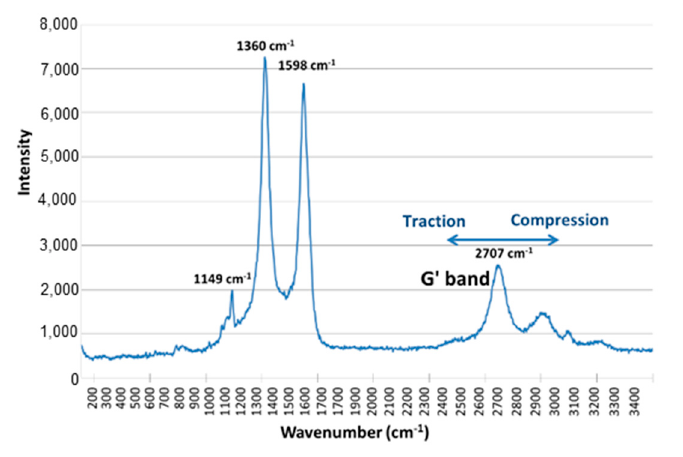
Figure 14. Raman spectrum of a MWNT-based agglomerate in DGEBA/DDS/MWNT nanocomposite (0.7 wt %, DD = 4.9).